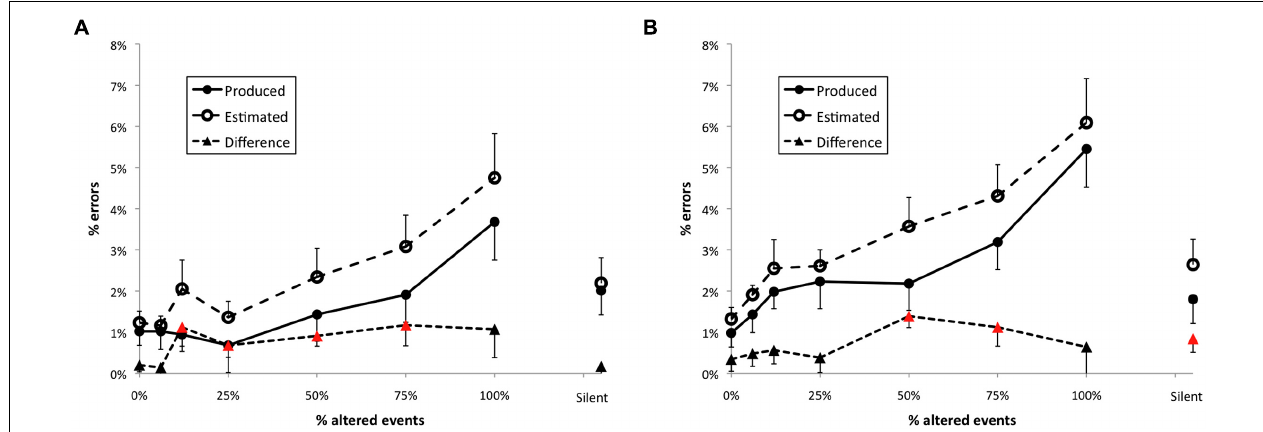
FIGURE 5 | Mean percent of errors per trial plotted by feedback condition for Experiment 2 for trials with no load (A) and with the load task (B). Error bars are equal to 1 SE of the mean; triangles plotted as red higlight those conditions for which the difference between produced and estimated error frequencies differed significantly from